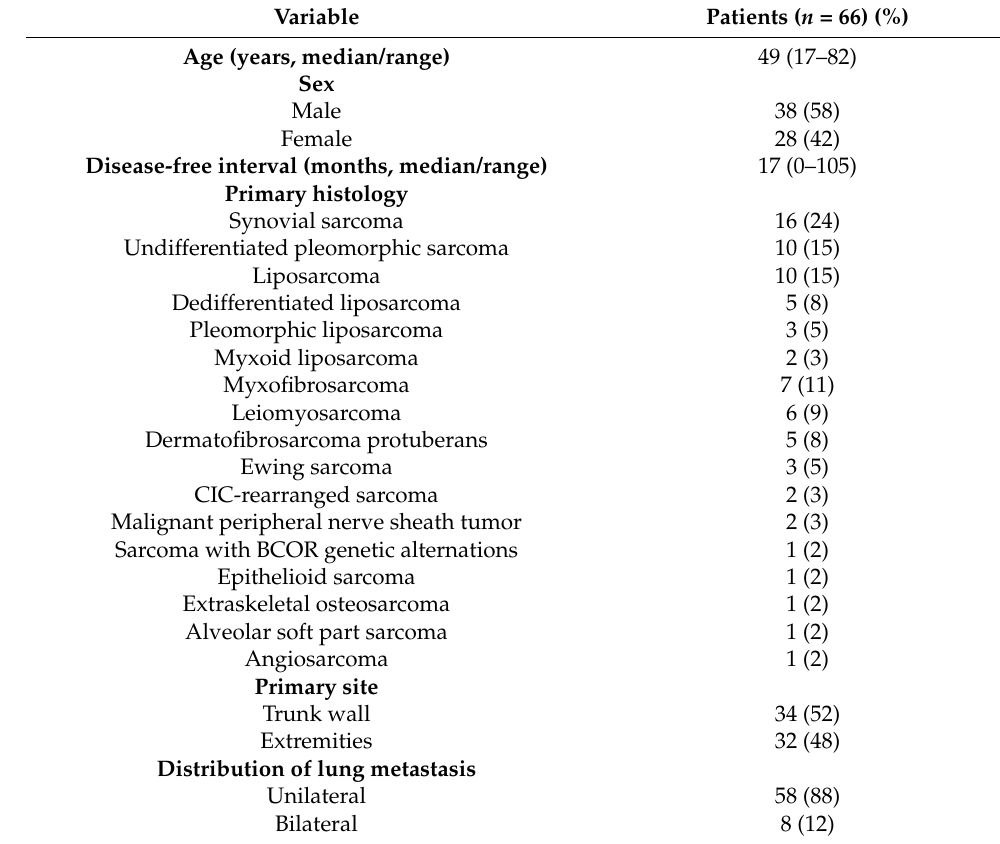
Table 1. Clinicopathological Characteristics of